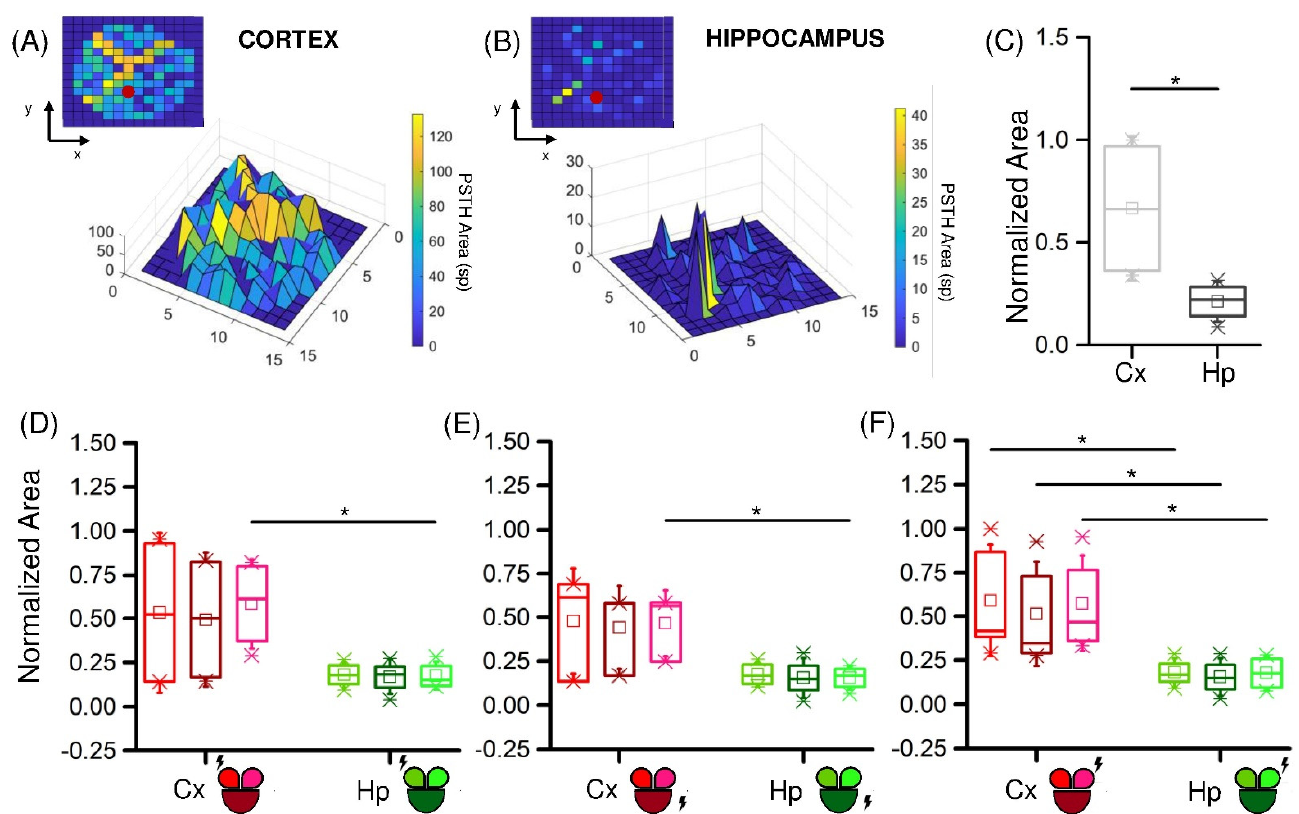
Figure 4. Cortical and hippocampal assemblies display different responsiveness when stimulated by low-frequency stimuli. Color- and height-coded representation of the PSTH area of a representative experiment with ( A ) Cx and ( B ) Hp neurons. ( C ) PSTH normalized area distributions of the Cx ( light grey ) and Hp ( dark grey ) assemblies. ( D – F ) Relevance of the site of stimulation (highlighted with a lightning sign) in cortical ( red ) and hippocampal ( green ) networks. (* refers to 0.01 < p < 0.05; Kruskal–Wallis nonparametric test).